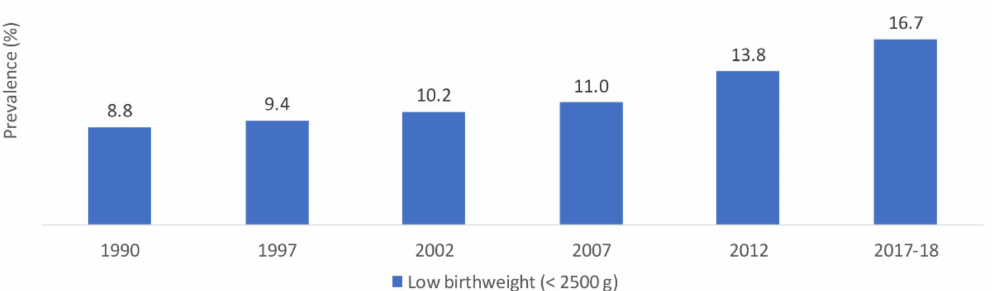
Figure 2. Trends in the prevalence (%) of low birthweight (<2500 g) in Jordan, national surveys (1990–2017). Source: DOS, 1992; DOS, 1998; DOS, 2003; DOS, 2008; DOS, 2013; DOS, 2019; Islam et al.,